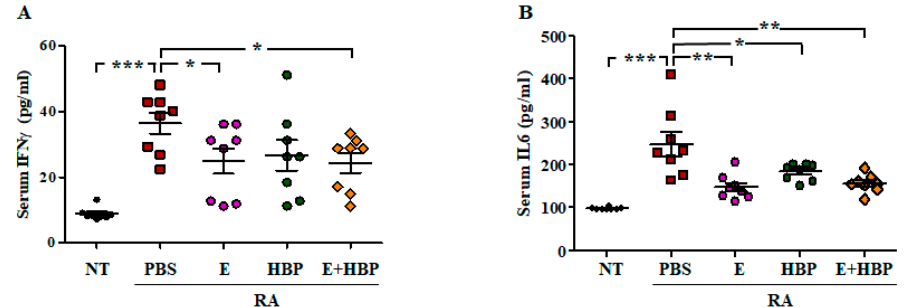
Figure 7. Comparison of serum cytokine levels among all experimental groups. Changes in serum IFN γ ( A ) and IL6 ( B ) concentrations in Enbrel ® and HBP-treated RA mice ( n = 10 per group). Statistical significance between groups was analyzed using the Student’s t -test. The level of significance is represented as * p < 0.05, ** p < 0.01, or *** p < 0.001.